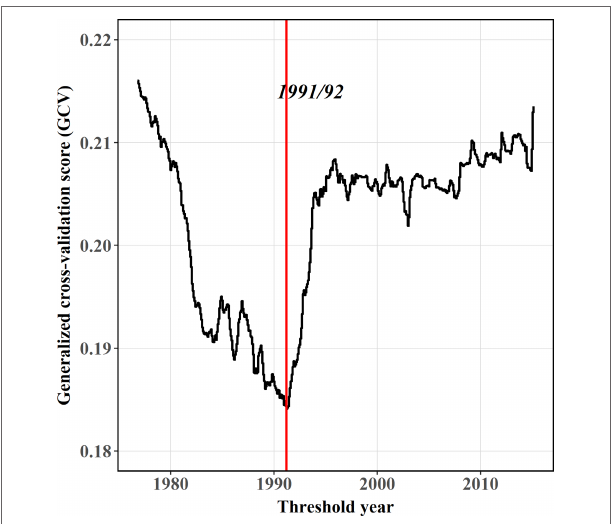
FIGURE 6 | Model comparisons between stationary and non-stationary models